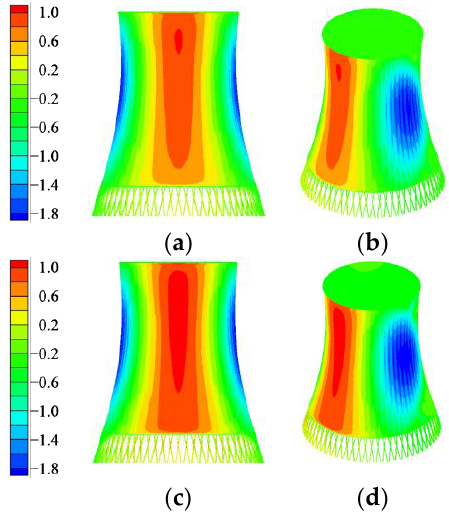
Figure 11. Comparison diagram of the pressure coefficients of cooling towers between typhoon and normal wind. ( a ) Front view of normal wind. ( b ) Overview of normal wind. ( c ) Front view of typhoon. ( d ) Overview of typhoon.